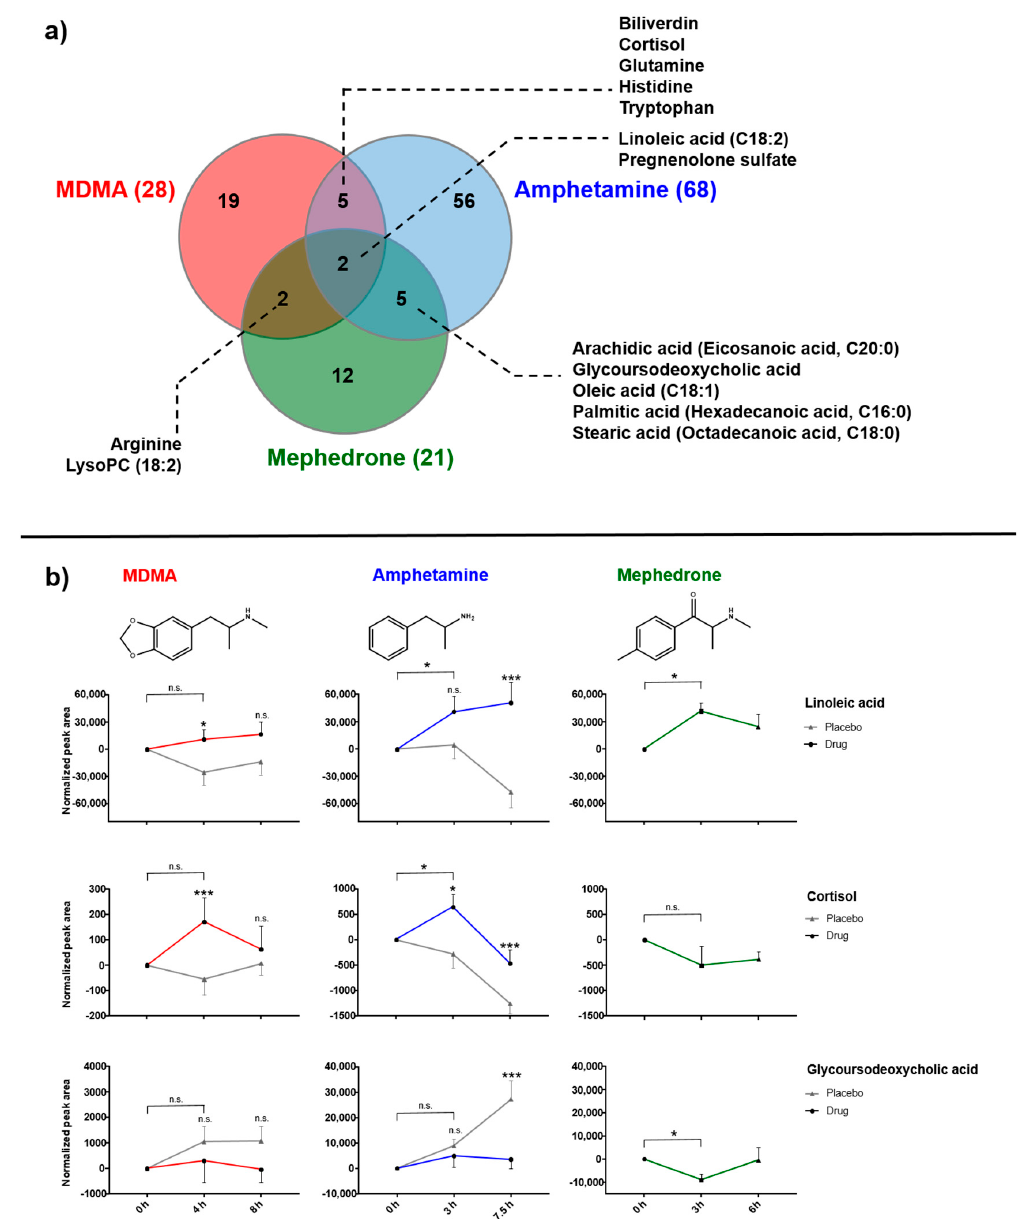
Figure 5. ( a ) Comparative analysis of identified, influenced features following MDMA (red), amphetamine (blue) and mephedrone (green) intake displayed as Venn-diagram. ( b ) Detailed changes over time for linoleic acid (upper panel), cortisol (middle panel) and glycocholic acid (lower panel). Colored lines indicate drug, light grey lines placebo intake, respectively. Data points represent mean and standard error of mean (SEM) of 16 and 13 replicates for MDMA and amphetamine, respectively. Mephedrone data display mean and standard deviation (SD) of n = 5 replicates. Statistical comparison was performed between placebo and drug intake and between time points 0 and 1 using paired t -tests ( p < 0.05; n.s. > 0.05; * 0.01–0.05; ***